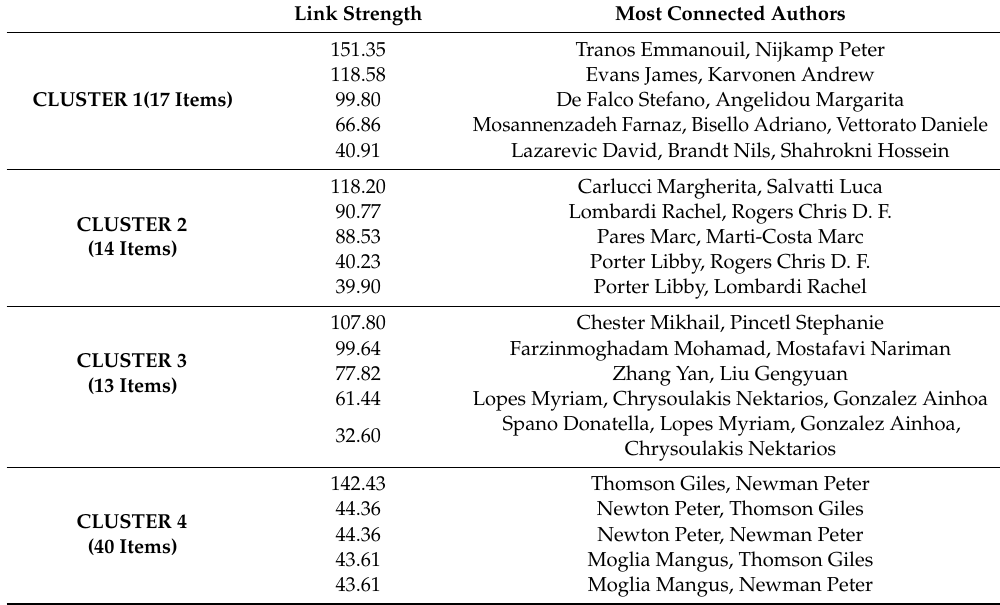
Figure 6. (a). Map of bibliographic coupling analysis based on authors (weights on the total link strength).( b ). Map of bibliographic coupling analysis based on authors with the weight on the number of documents and indicating the number of average citations. Table 5. Most connected authors per infometric